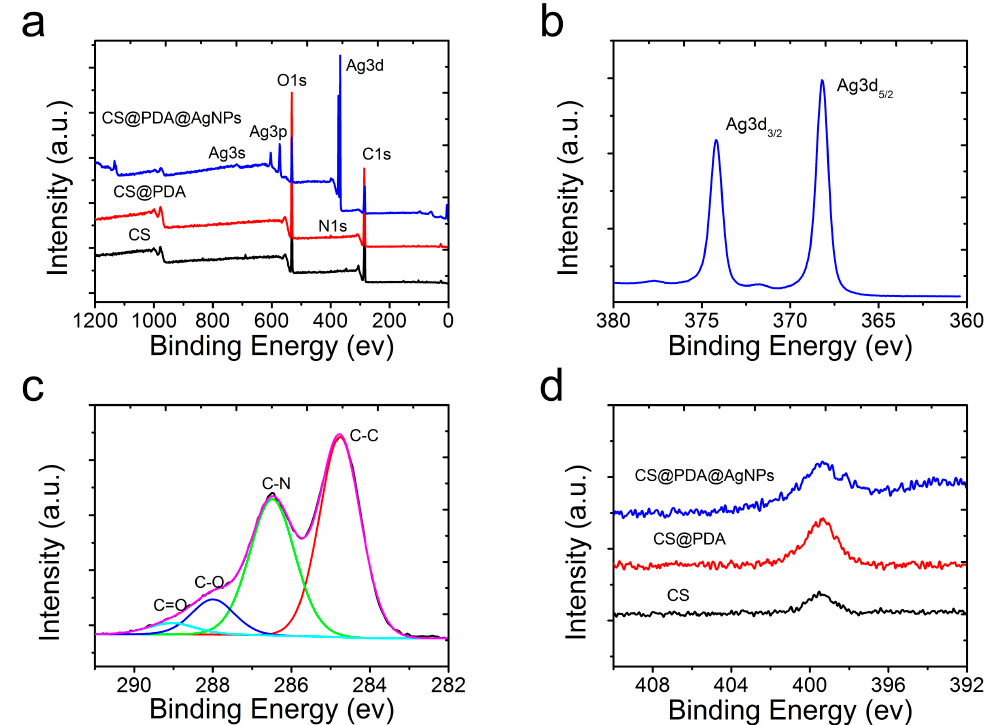
Figure 3. ( a ) XPS survey of the original cotton swabs, CS@PDA swabs and CS@PDA@AgNPs swabs.